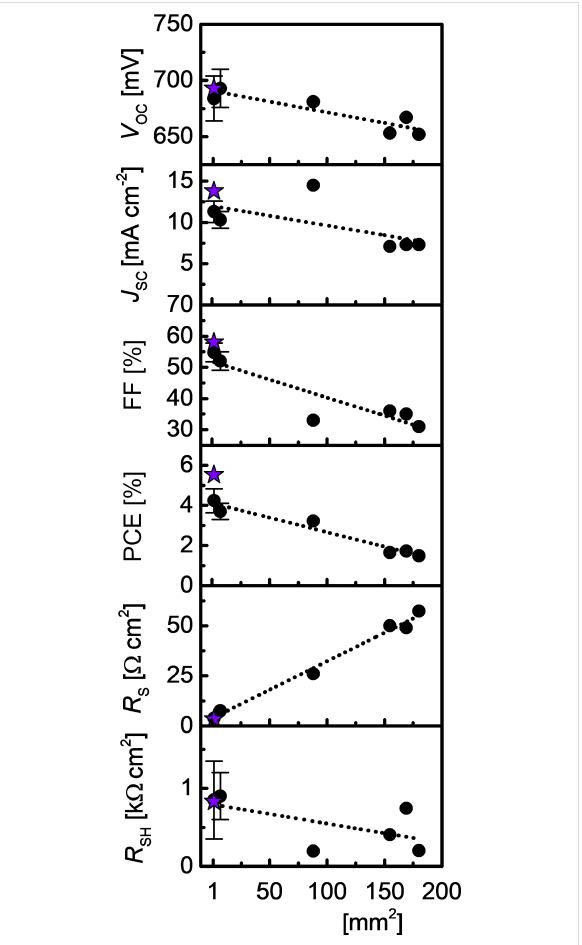
Figure 5: Photoconversion parameters of 100 nm Sb 2 S 3 solar cells under illumination at AM1.5G as a function of cell area. The dotted lines are a guide to the eye; the purple star signifies the best-per- forming 1.7 mm 2 cell with 5.5% PCE. The vertical bars signify stan- dard deviation, and black dots represent either average values of smaller cells (area <10 mm 2 ), or individual values of larger cells (area >10 mm 2